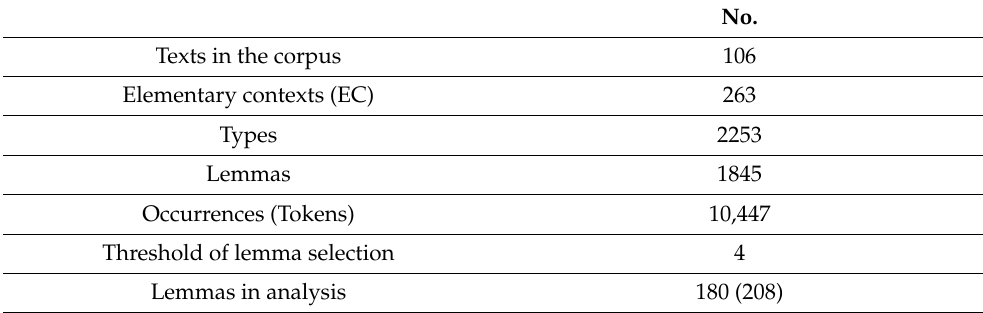
Table 2. Characteristics of the dataset.